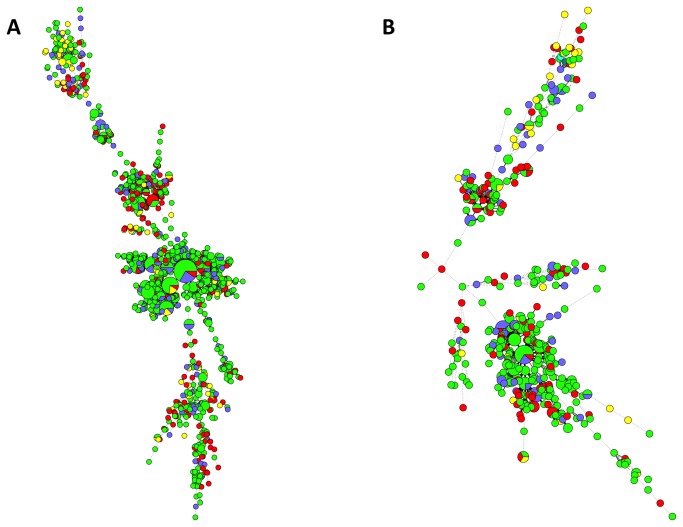
Minimum spanning trees of MTC isolates typed via both spoligotyping and MIRU-VNTR, categorized according to patient ethnicity (yellow = Indian, green = Chinese, blue = Malay, red = others).Each circle represents a genotype and the sizes of the circles are proportionate to the number of members in each group. The distance between circles represents how closely related the different genotypes are to each other. 2A) MTC isolates from the earlier 2006-2007 phase. 2B) MTC isolates from the later 2008-2012 phase.